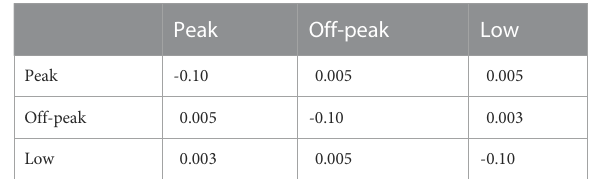
TABLE 2 Self and cross elasticities.